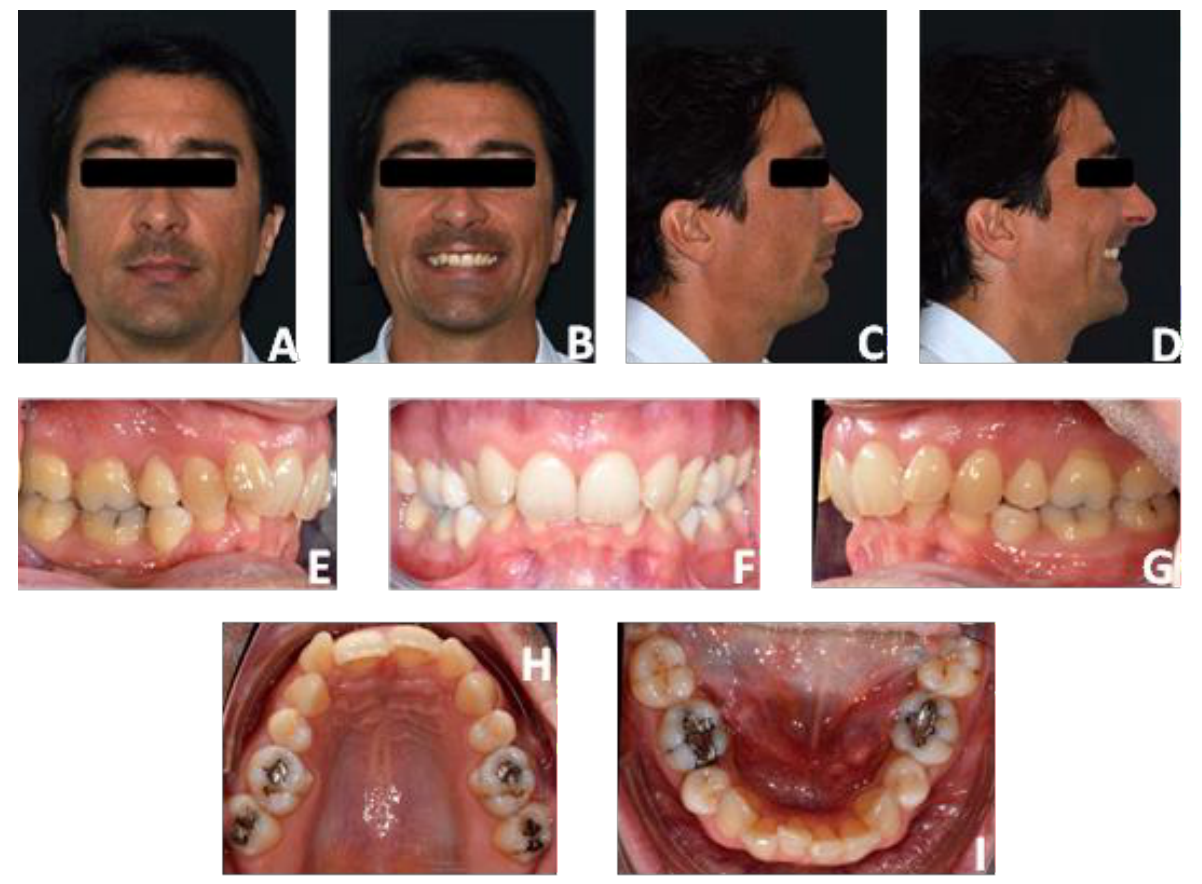
Figure 9. Pre-treatment intraoral and extraoral photos of case number 1: frontal facial view ( A ); frontal facial view smiling ( B ); right facial view ( C ); right facial view smiling ( D ); Right arches view ( E ); Frontal arches view ( F ); Left arches view ( G ); upper arch occlusal view ( H ); lower arch occlusal view ( I ).